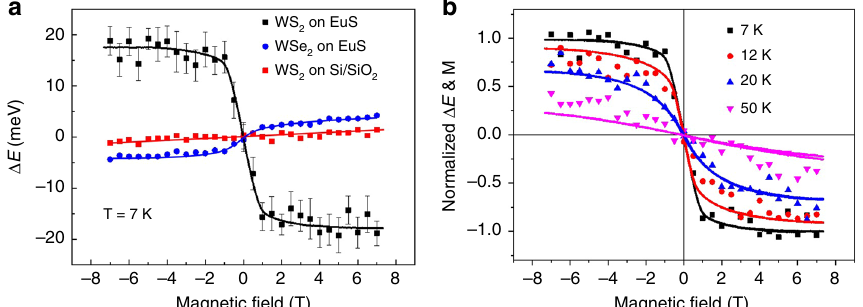
Fig. 3 Valley Zeeman splitting in Monolayer WS 2 . a Field dependent valley exciton splitting Δ E of WS 2 /EuS (black squares), WS 2 /SiO 2 (red squares), and WSe 2 /EuS (blue circles) measured at 7 K. The lines serve as guide to the eye. b Field-dependent valley splitting Δ E of WS 2 /EuS and magnetization M of EuS measured in 7, 12, 20, and 50 K superimposed on each other. Both Δ E and M are normalized by their saturation values at 7 K. Points, normalized Δ E ; lines, normalized